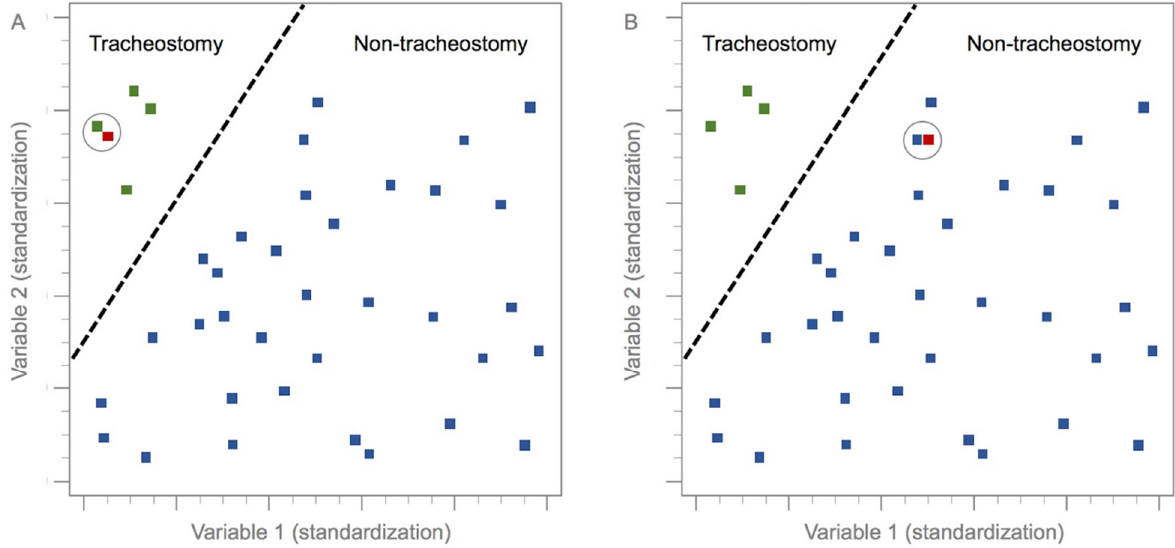
Figure 3. Diagram of the k -nearest neighbor model. In ( A , B ), green dots represent training group patients who underwent tracheostomy, and blue dots represent training patients who did not undergo tracheostomy. Red dots represent test group patients. The dotted line distinguishes cases in which tracheostomy was performed from those in which it was not performed. The circles are the nearest neighbors to test and training group instances.